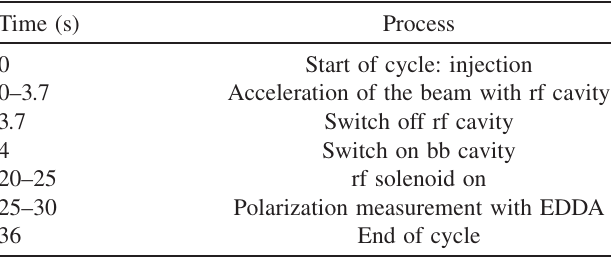
TABLE I. Cycle timings used to determine the spin-resonance frequency spectrum with the polarized